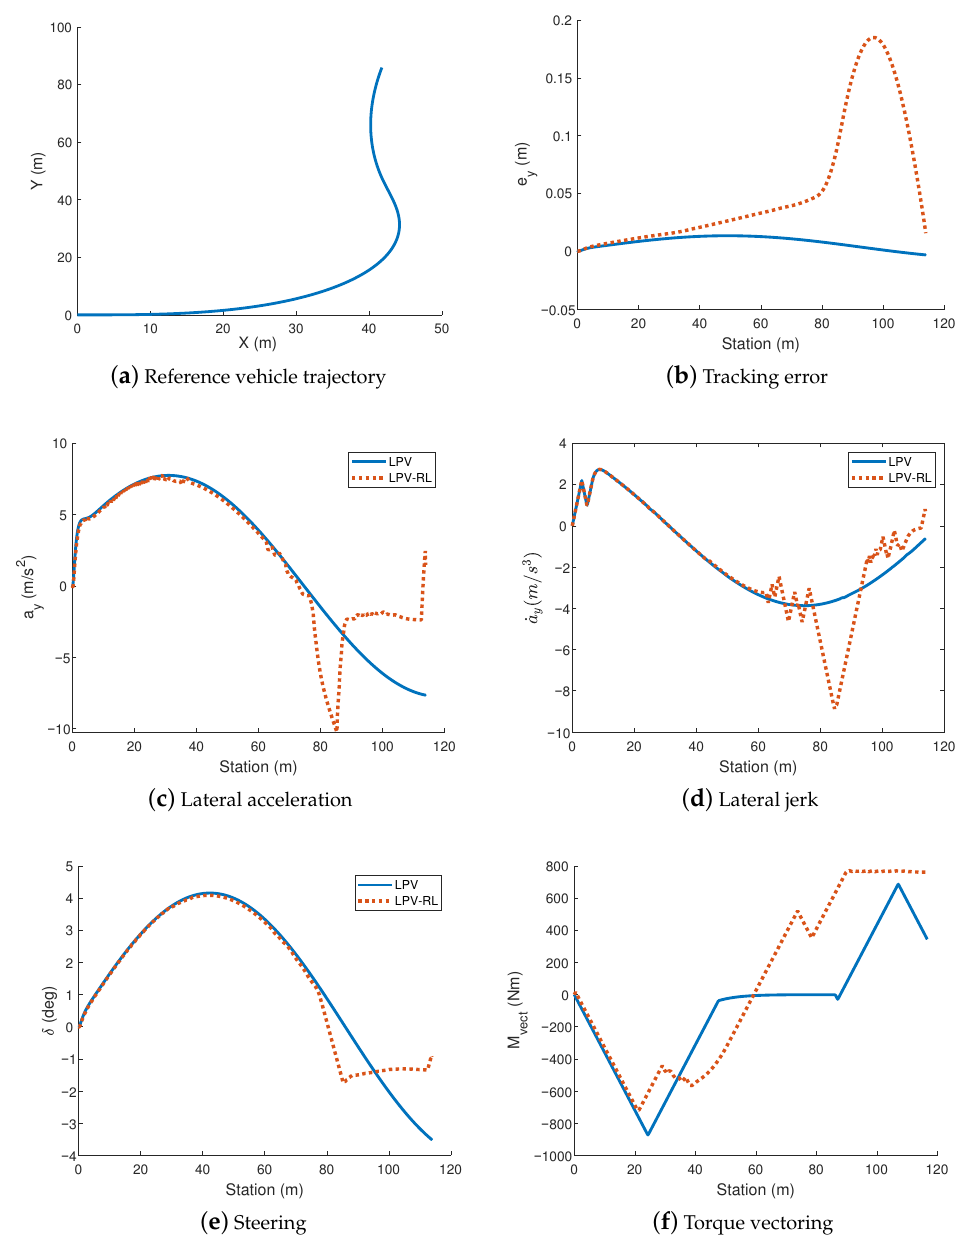
Figure 7. Simulation results with extended